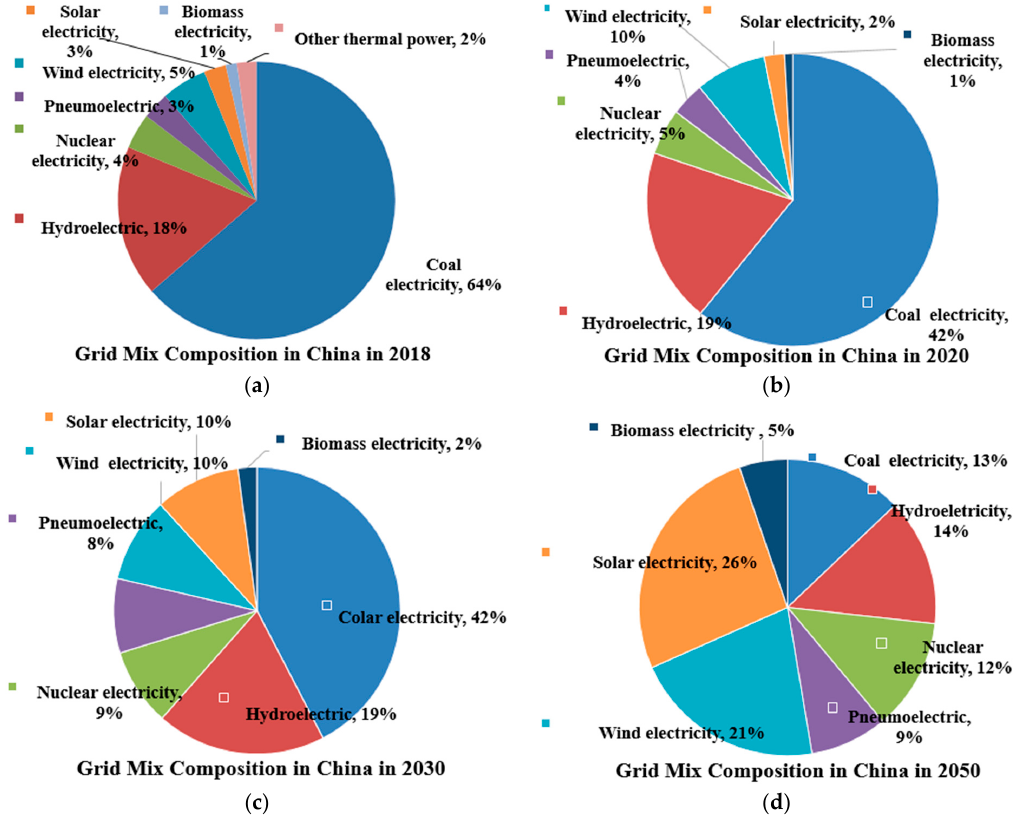
Figure 3. ( a ) China’s grid mix composition and ratio in 2018; ( b ) China’s grid mix composition and ratio forecast for 2020; ( c ) China’s grid mix composition and ratio forecast for 2030; ( d ) China’s grid mix composition and ratio forecast for 2050.